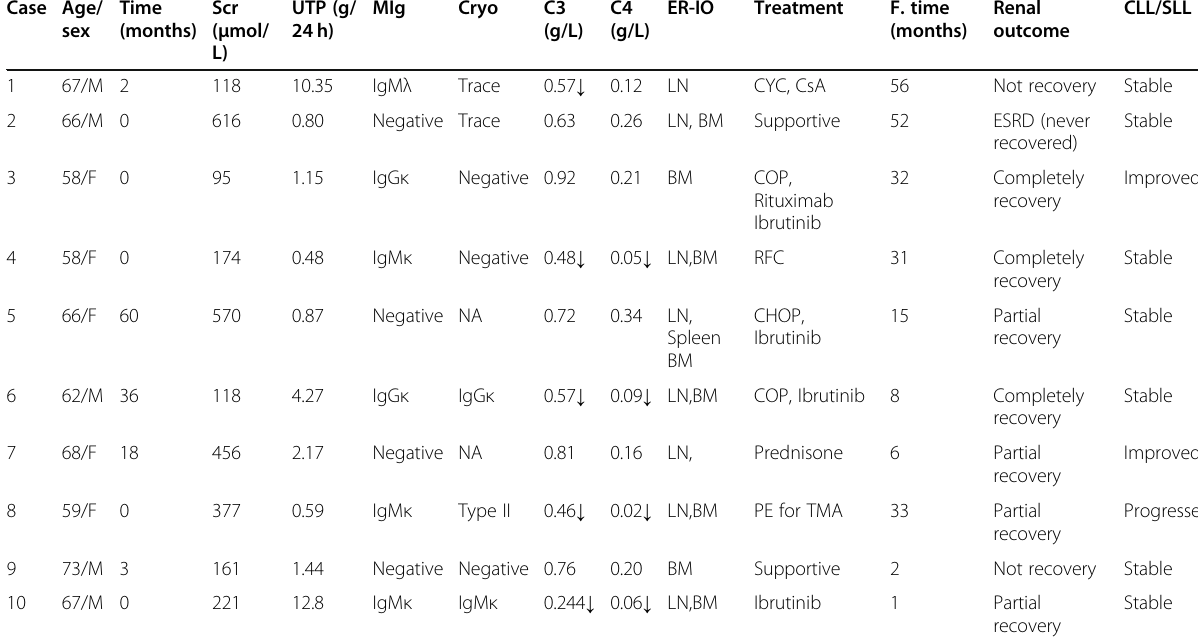
Table 1 The clinical features of CLL/SLL